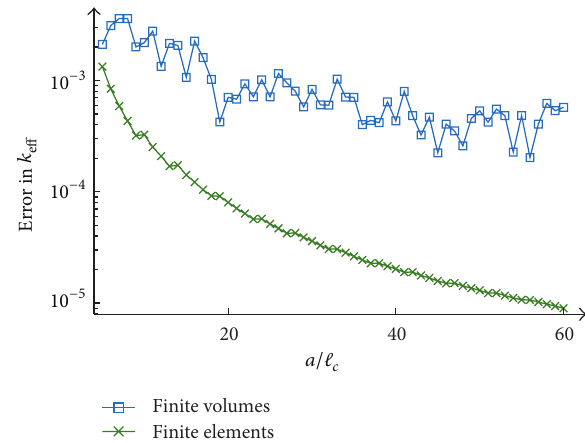
Figure 9: The 2D IAEA PWR benchmark